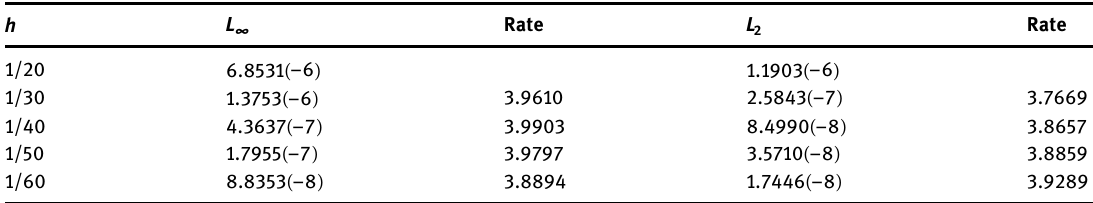
Table 14: L 2 , L ∞ errors when = τ h 2 and = T 0.1 by the HOC - LOD scheme at variable h for Example